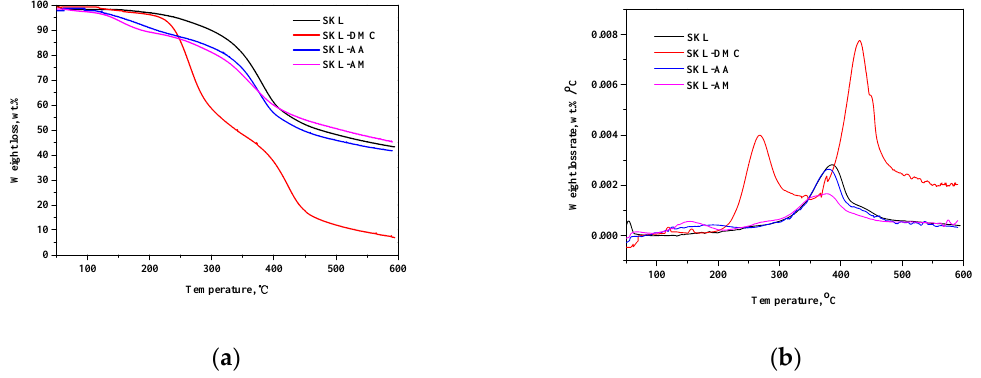
Figure 4. ( a ) Weight loss of SKL and SKL copolymers; ( b ) weight loss rate of SKL and SKL copolymers.